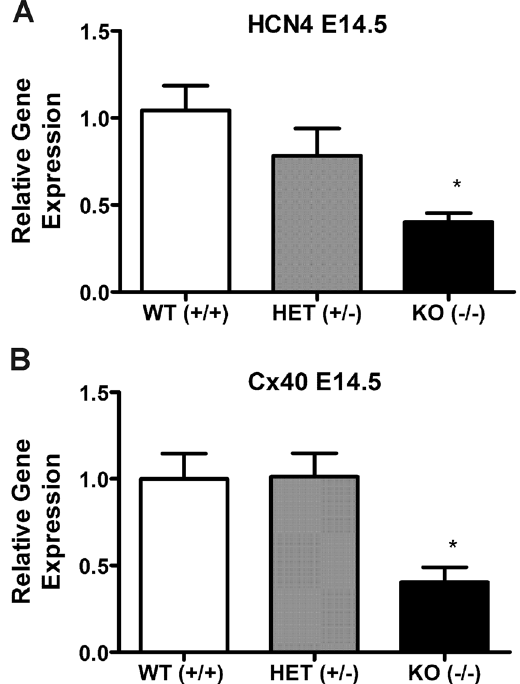
Figure 5. Gene expression of HCN4 and Cx40 in NPRA wild type (WT), heterozygous (HET) and knockout (KO) ventricles at E14.5 stage. RT-qPCR analysis was used to monitor HCN4 ( A ) and Cx40 ( B ) gene expression levels in the ventricles of indicated NPRA genotypes. Expression levels were normalized to GAPDH via ∆∆ C T method. Relative expression levels were presented as fold changes in comparison to the levels in WT. N = 8–13 independent RNA extractions/genotype for both panels, each bar represents mean ± SEM, * P < 0.05 Vs. WT for HCN4 gene expression and * P < 0.05 Vs. WT or HET for Cx40 gene expression. One-way ANOVA with Tukey’s multiple comparisons post hoc